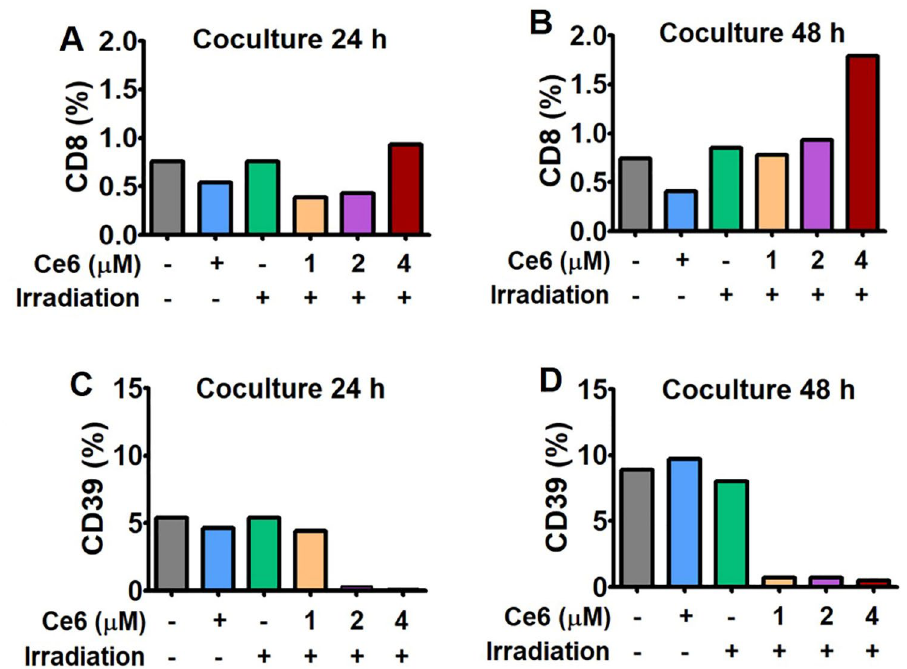
Figure 9. Augmentation of cytotoxic T cells and deduction of CD39 + Treg cells through the blockage of PD-1/ PD-L1 interaction by Ce6-PDT. PD-L1 aAPC/CHO-K1 cells were plated and incubated at 37 °C for 20 h prior to the addition of PD-1 effector cells. Cells were treated with an increasing concentrations of Ce6 (1–4 µM) followed by PDT. The concentration of Ce6 only is 4 μΜ. PD-1/PD-L1 immune check-point blockage by Ce6-PDT was analyzed to measure the CD8 + T cells and CD39 + T cells ( A ), ( C ) in 24 h and ( B ), ( D ) in 48 h of coculture respectively. Data are presented as the means